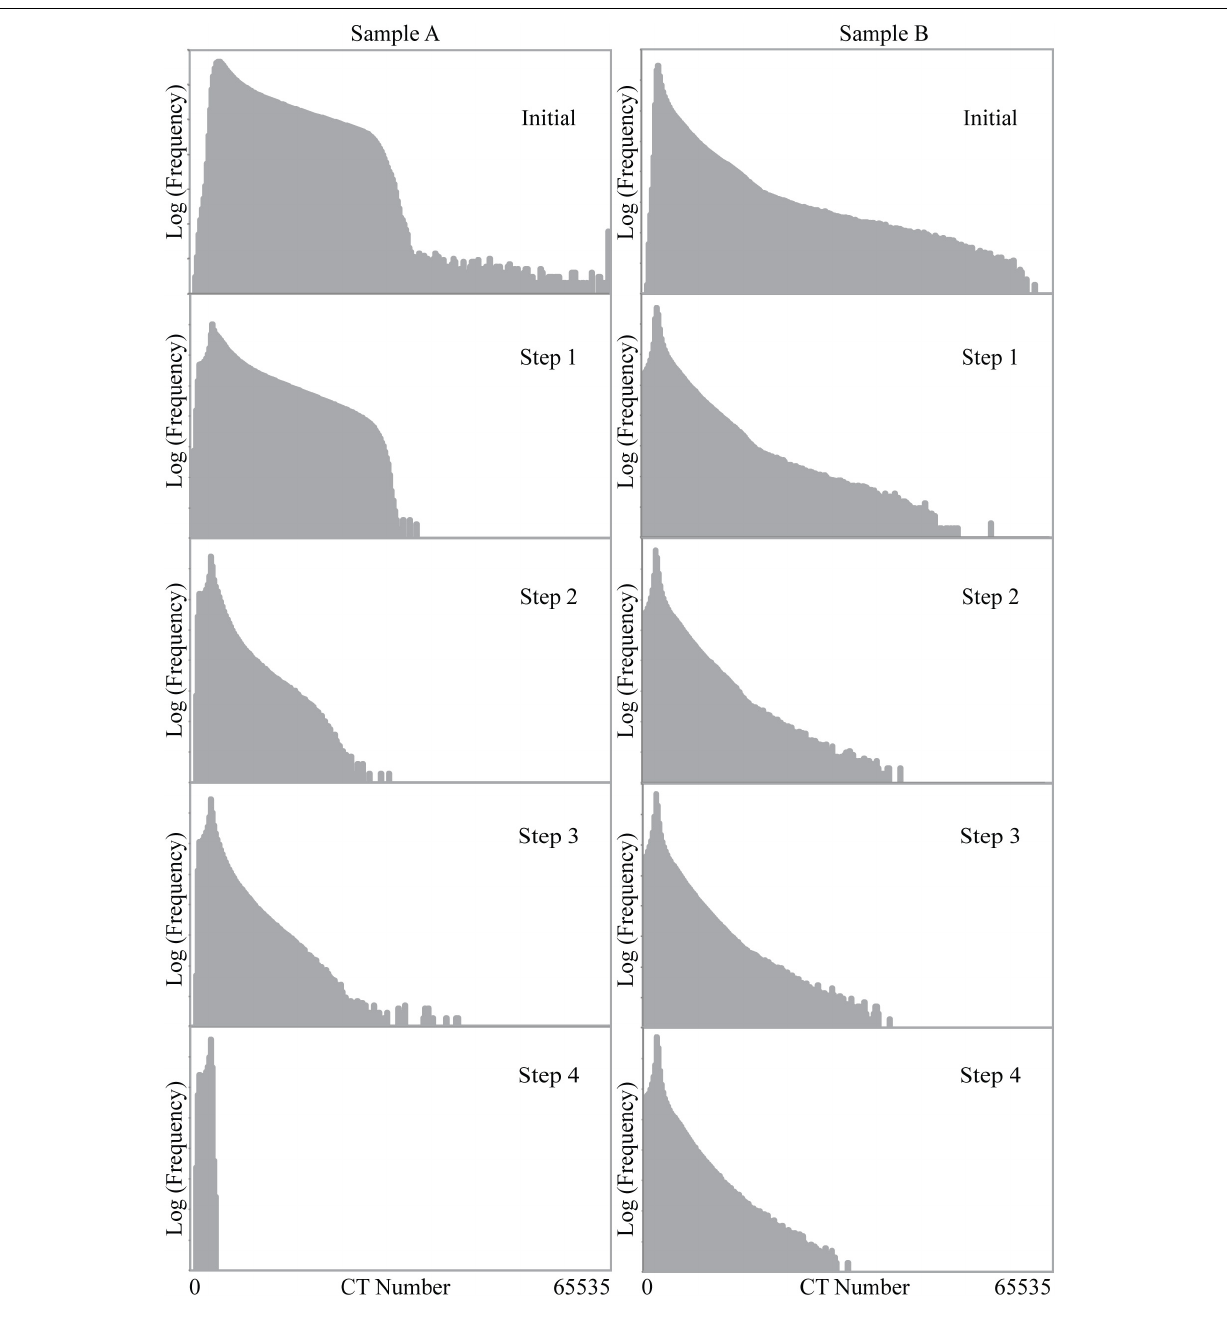
FIGURE 5 | Histograms of voxel CT number values for both samples after each acid leaching